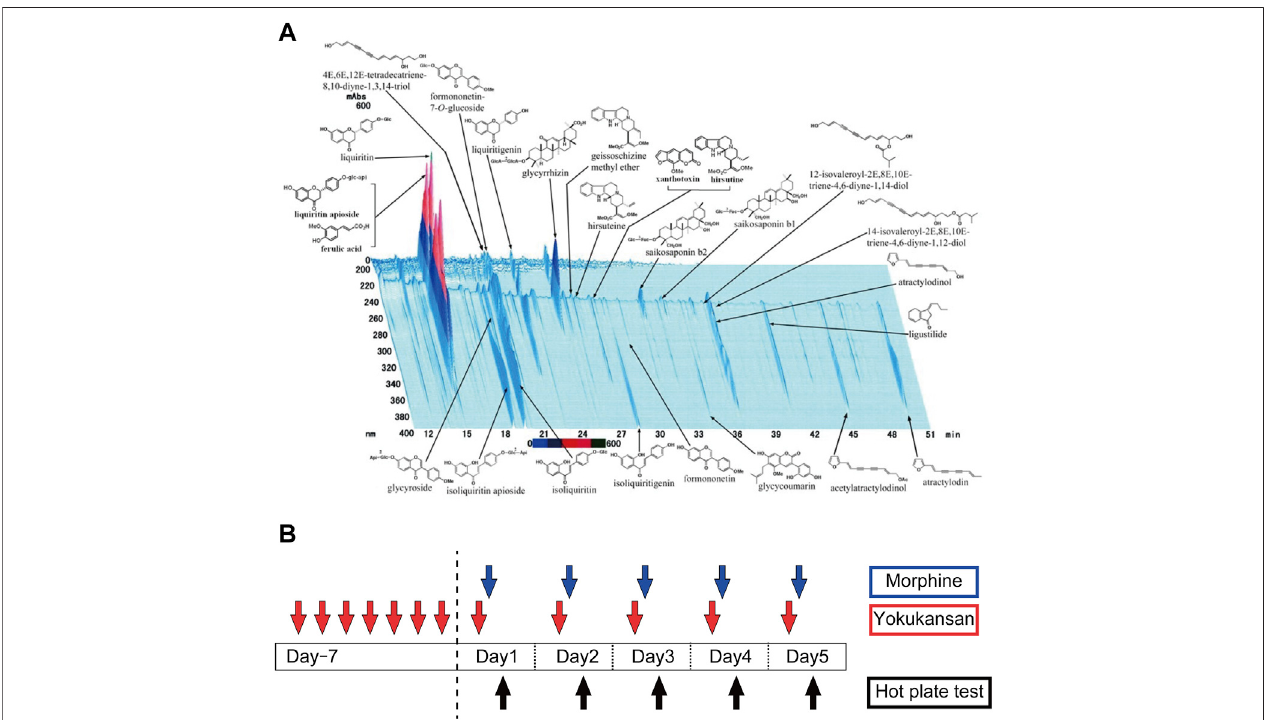
FIGURE 1 | (A) Constituents of the YKS extract identi fi ed by 3D-HPLC (provided by Tsumura and Co.). See details (Ikarashi and Mizoguchi, 2016) (B) The experimental schedule to develop a morphine antinociceptive tolerance rat model and to clarify the inhibitory effect of YKS on morphine tolerance. Morphine tolerant model rats were developed by subcutaneous injection of morphine (10 mg/kg/day) daily for 5 days and oral administration of YKS (0.3 g/kg or 1.0 g/kg/day) started 7 days before the fi rst morphine injection. Morphine was injected 30 min after YKS administration. The hot plate test was performed 1 h after morphine injection. Spinal cord samples for Western blotting and immunohistochemistry were collected on Day